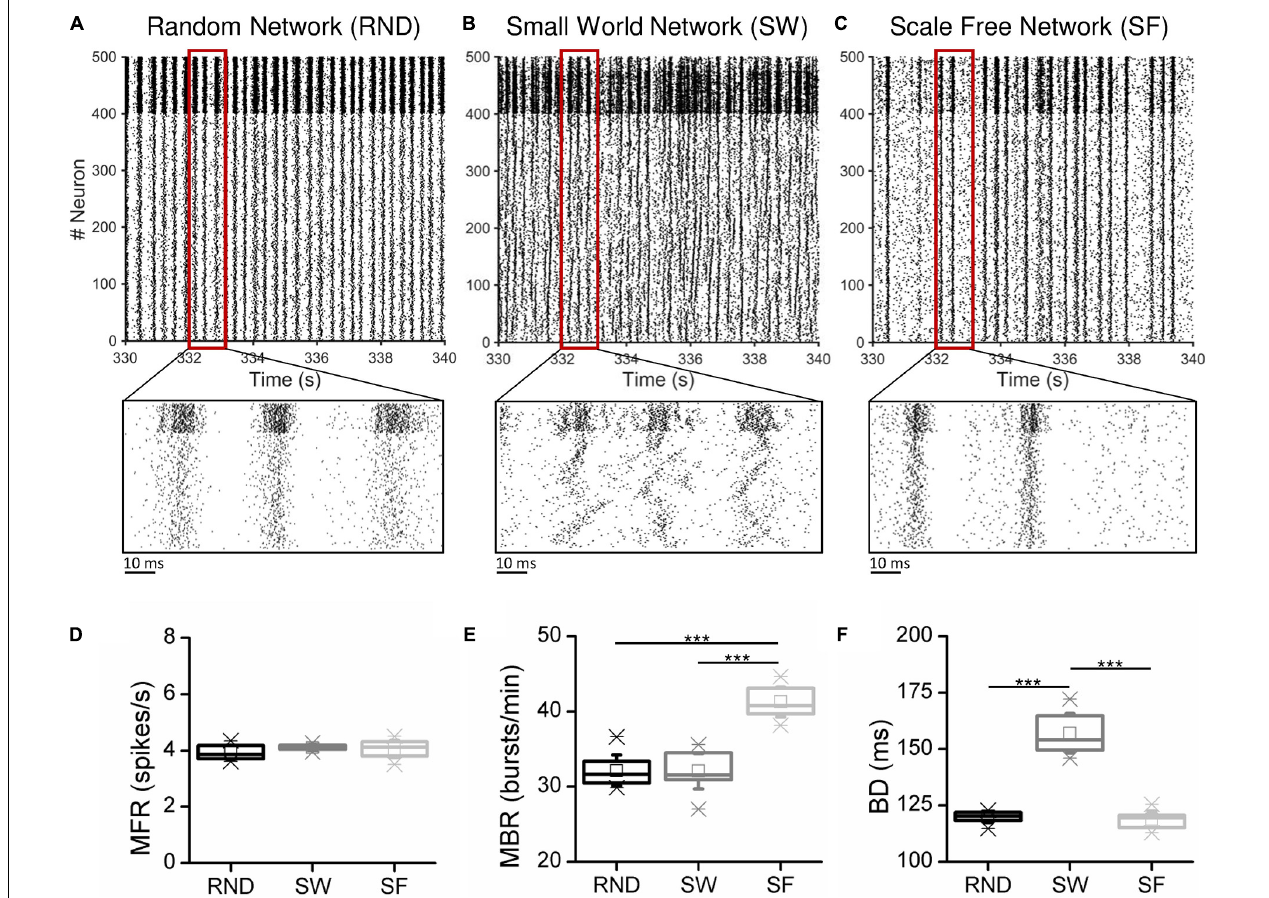
FIGURE 2 | Simulated spontaneous activity of a representative (A) Random, (B) Small-World, and (C) Scale-Free network. The close-ups magnify 2 s of activity. (D) Mean firing rate (MFR), (E) mean bursting rate (MBR), and (F) burst duration (BD) averaged over 15 simulations for each topology (*** p < 0.001, Kruskal–Wallis, non-parametric